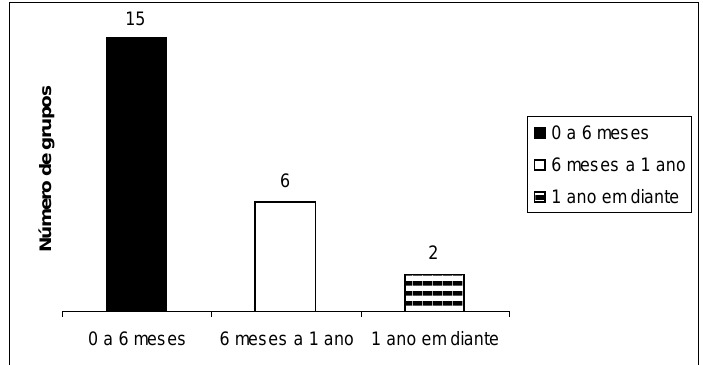
Figura 7. Distribuição das atualizações dos grupos de pesquisa por